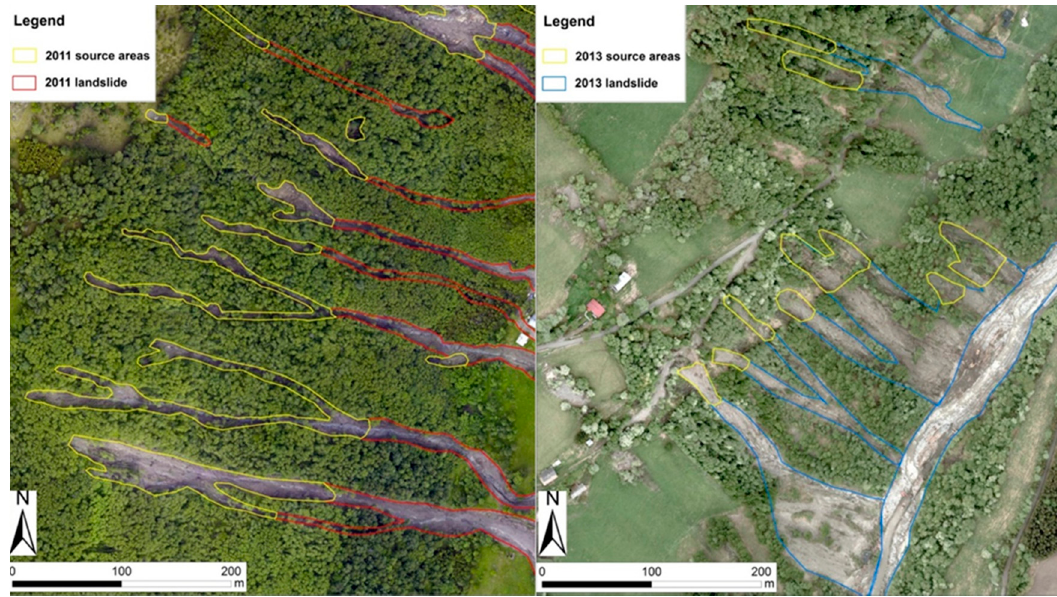
Figure 2. Mapped landslides resulting from the analysis of high-resolution aerial orthophotos taken after the 2011 ( left ) and 2013 ( right ) landslide events.